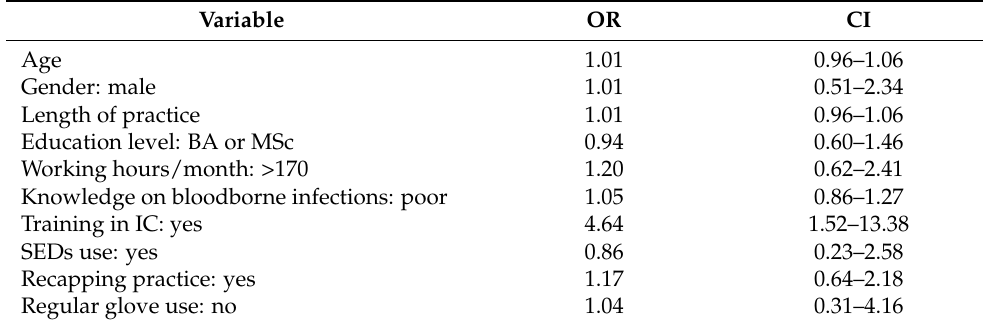
Table 3. Logistic-regression model: association of SIs with selected variables (odds ratios) ORs estimates *, 95% confidence intervals (CIs) of OR estimates; n = 286.